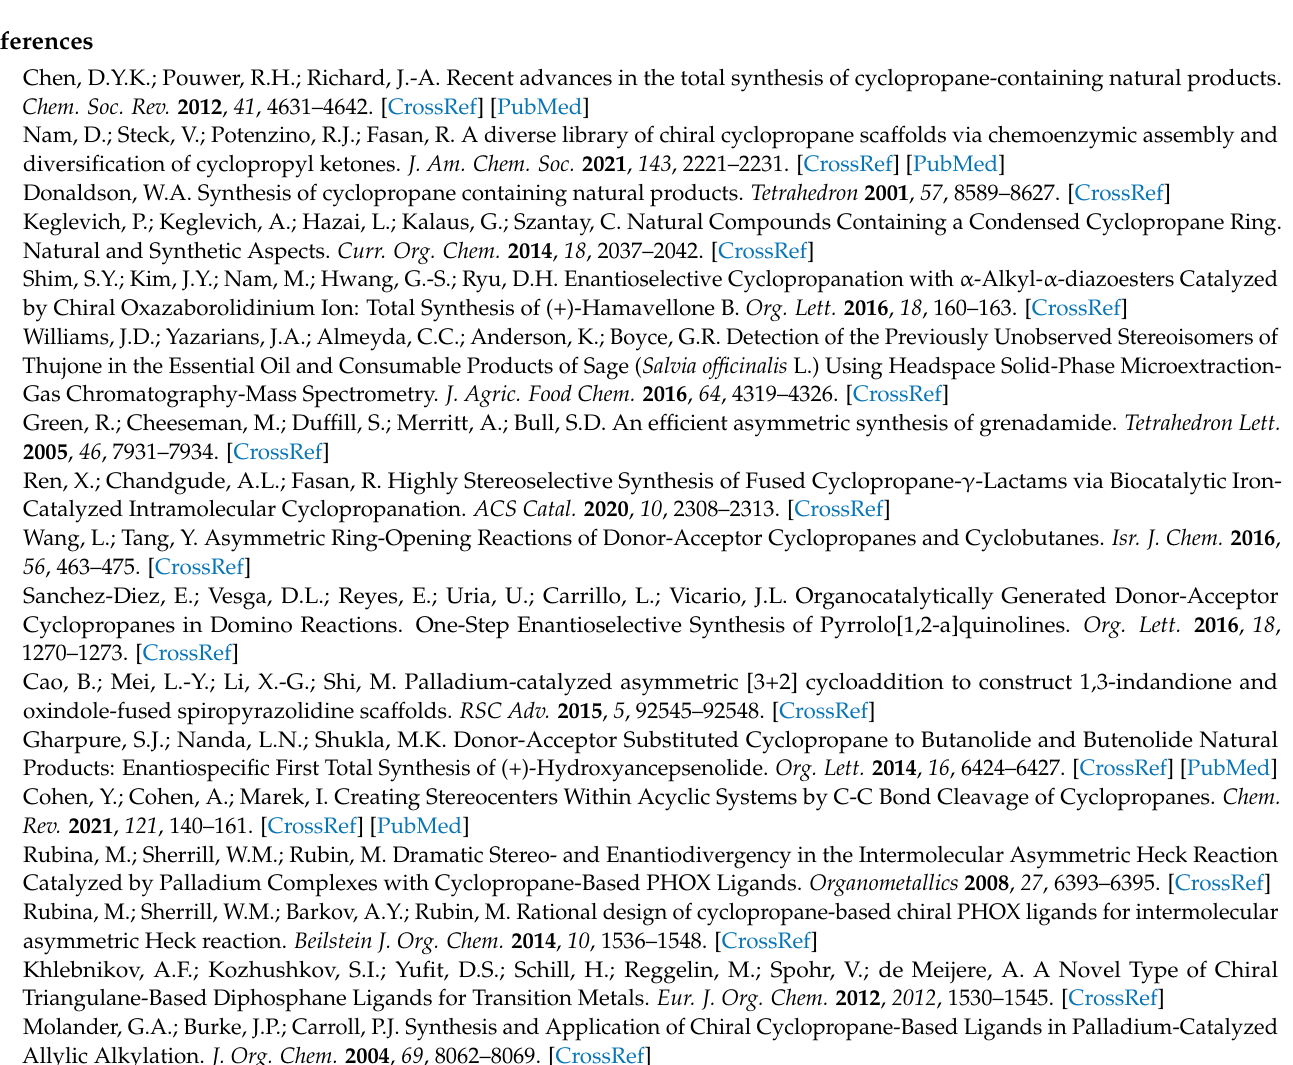
Figure S24. 13C NMR spectrum of compound 23dae . Figure S25. 1H NMR spectrum of compound 23dal . Figure S26. 13C NMR spectrum of compound 23dal . Figure S27. 1H NMR spectrum of compound 23cag . Figure S28. 13C NMR spectrum of compound 23cag . Figure S29. 1H NMR spectrum of compound 23cah . Figure S30. 13C NMR spectrum of compound 23cah . Figure S31. 1H NMR spectrum of compound 23cad . Figure S32. 13C NMR spectrum of compound 23cad